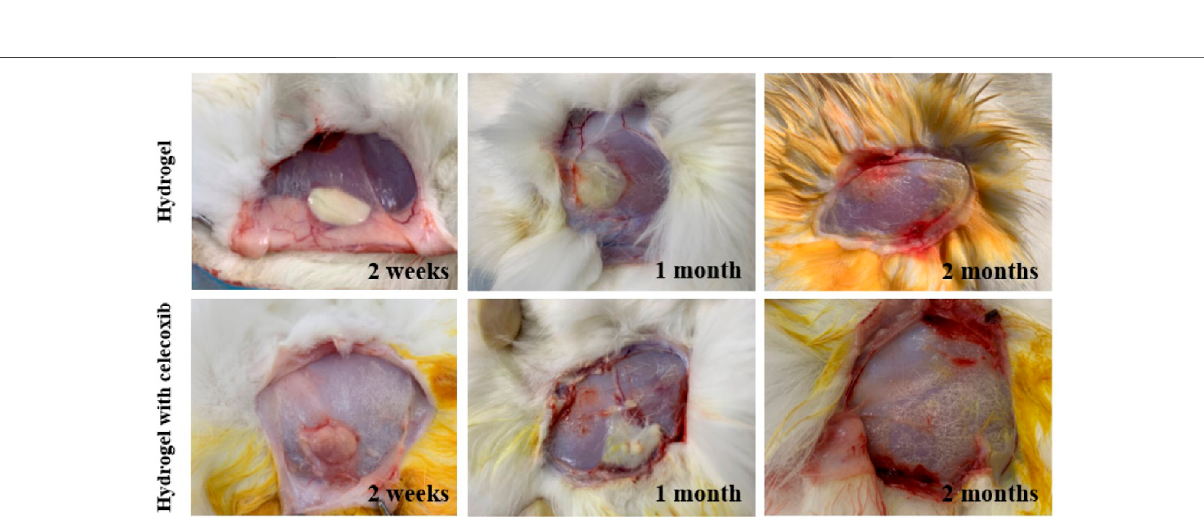
Frontiers in Bioengineering and Biotechnology |